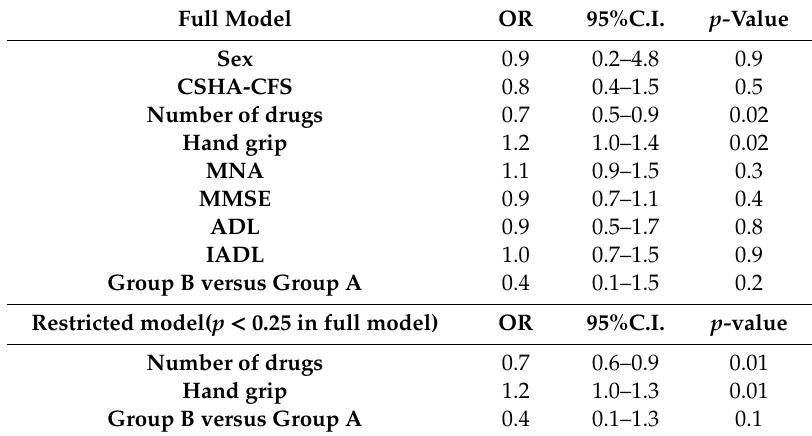
Table 2. Logistic regression models for the prediction of successful